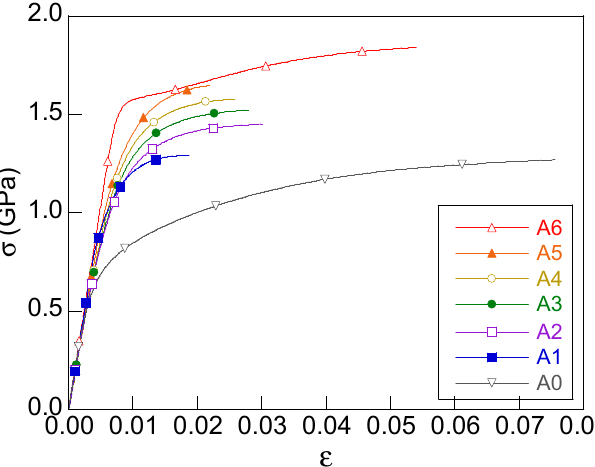
Figure 5. Stress–strain curves of the progressively drawn pearlitic steels A0 to A6 (steel family A: from 0 to 6 cold-drawing steps).